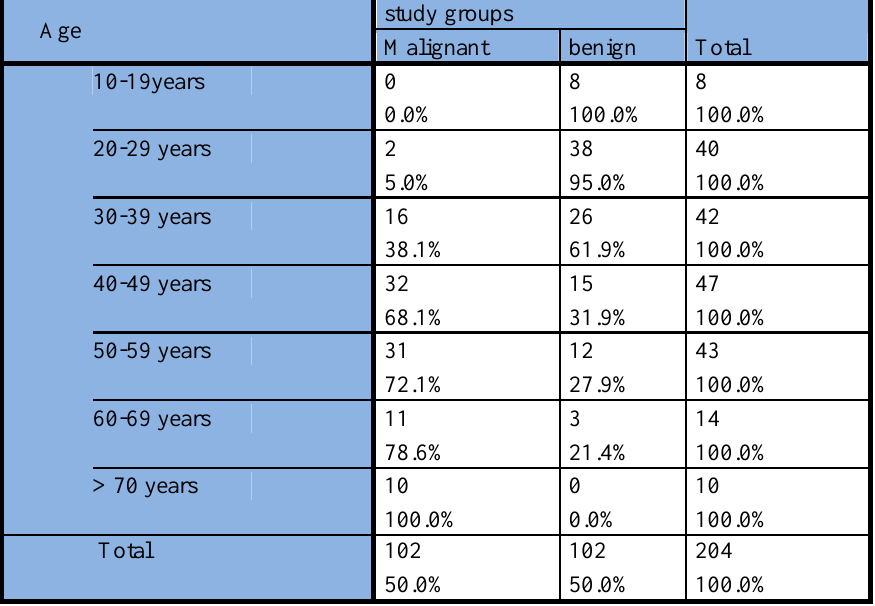
Table 1 the age distribution of study groups Age